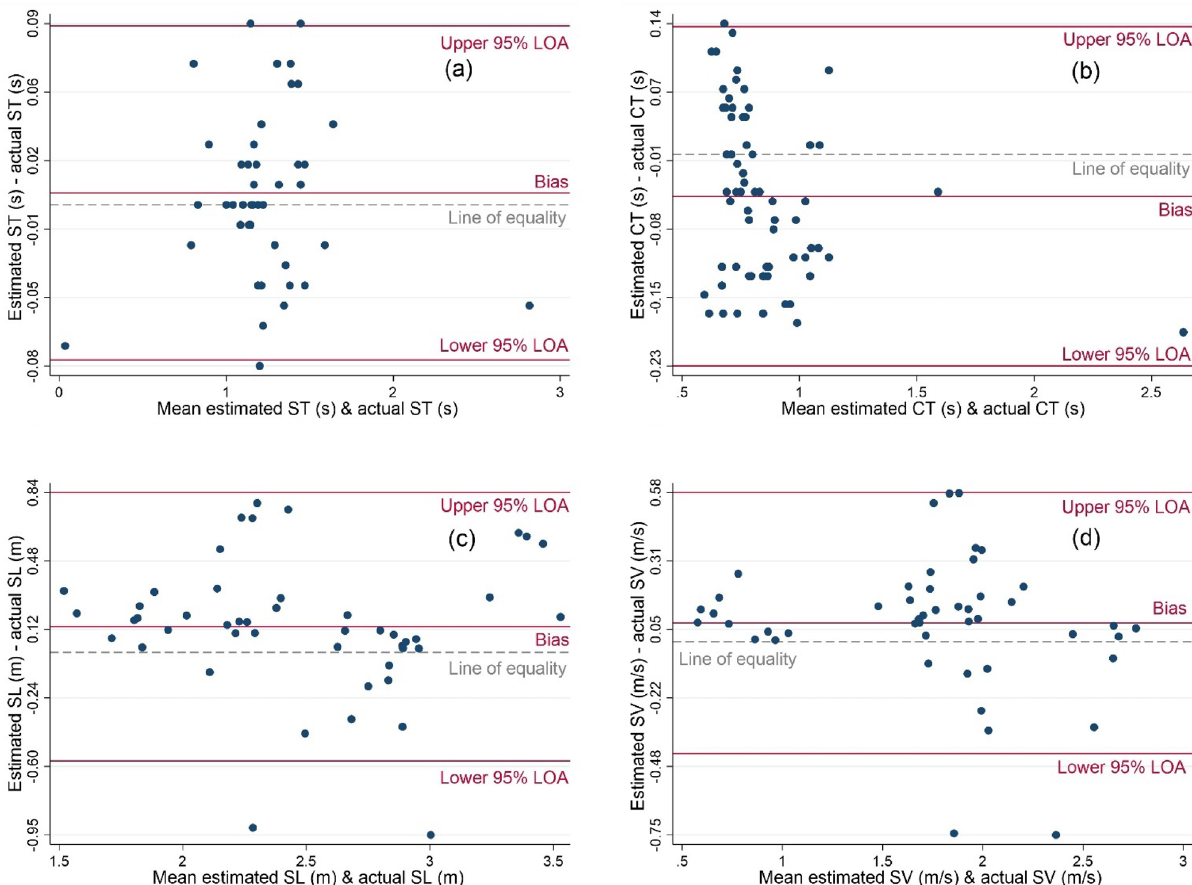
Figure 4. Bland–Altman plot modified for the repeated measures plotted for the ST ( a ), CT ( b ), SL ( c ), and SV ( d ) "estimated" by the IMU readouts against the "actual" ones obtained by the reference systems (pressure insoles for ST and CT, and motion capture system for SL and SV). Also, the lines of bias, upper 95% LOA (limits of agreement), lower 95% LOA, and the line of equality (i.e., line of zero error) are shown. The plot suggests no apparent relationship between the errors of the IMU-based developed methods and the magnitude of the temporal and spatial